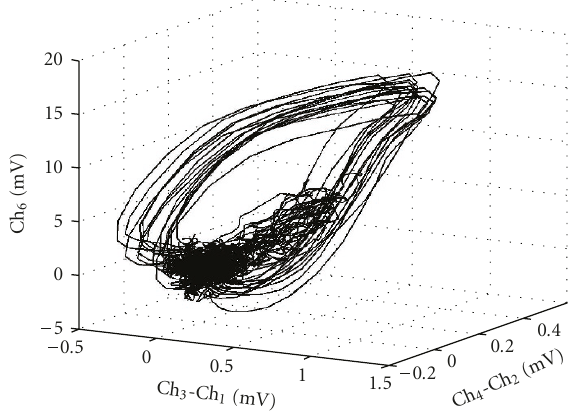
Figure 10: Synthetic mixture of the maternal and fetal VCGs, using a combination of the leads defined in Table